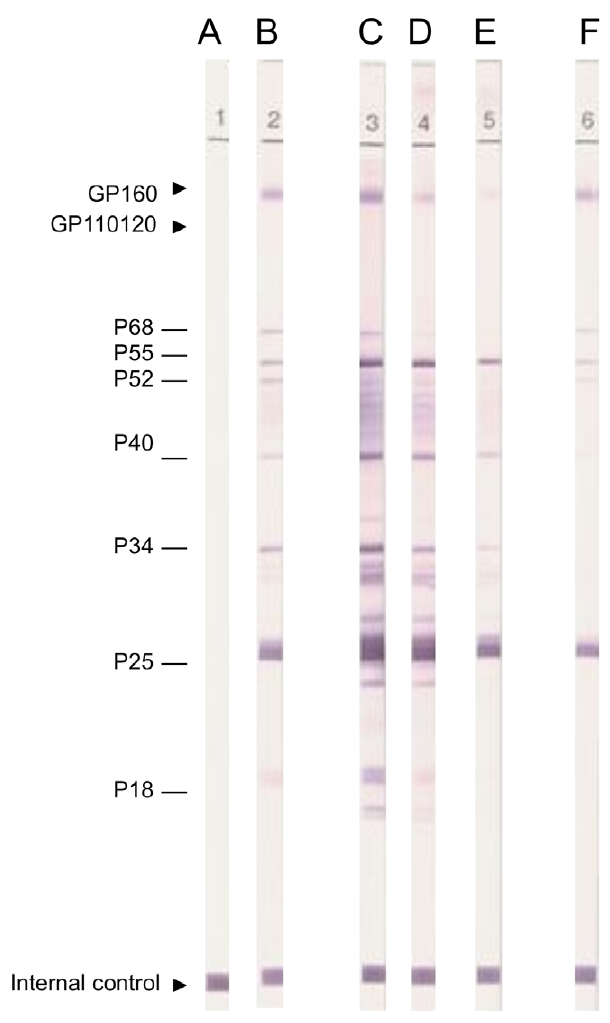
Figure 1. Western blot profiles of SIV-positive chimpanzees from Gabon. Plasma samples from chimpanzees Gab3 and Gab4 were tested for the presence of HIV-1 cross-reactive antibodies by western immunoblotting. Strips A and B are negative and positive controls, respectively. Progressive loss of HIV-cross-reactive antibodies in chimpanzee Gab3 is represented on strips C (at arrival, age 1 month), D (2 months), and E (death at 3 months). Strip F illustrates the HIV-1 cross-reactivity in plasma from chimpanzee